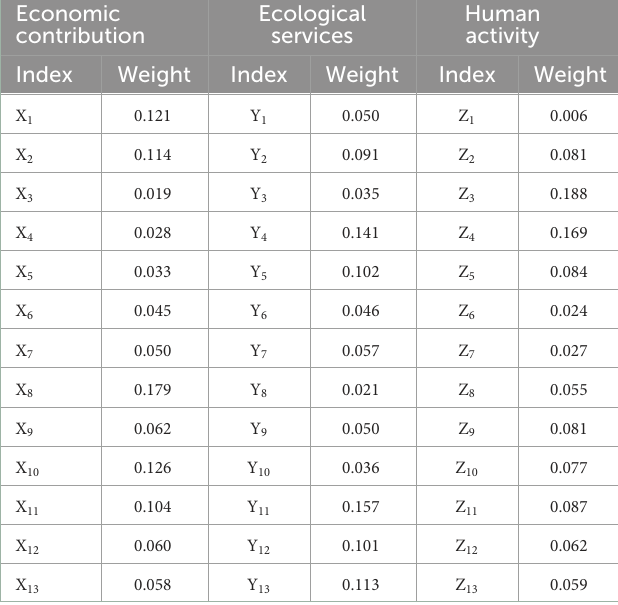
TABLE 6 Index weight of coastal ecosystem carrying capacity